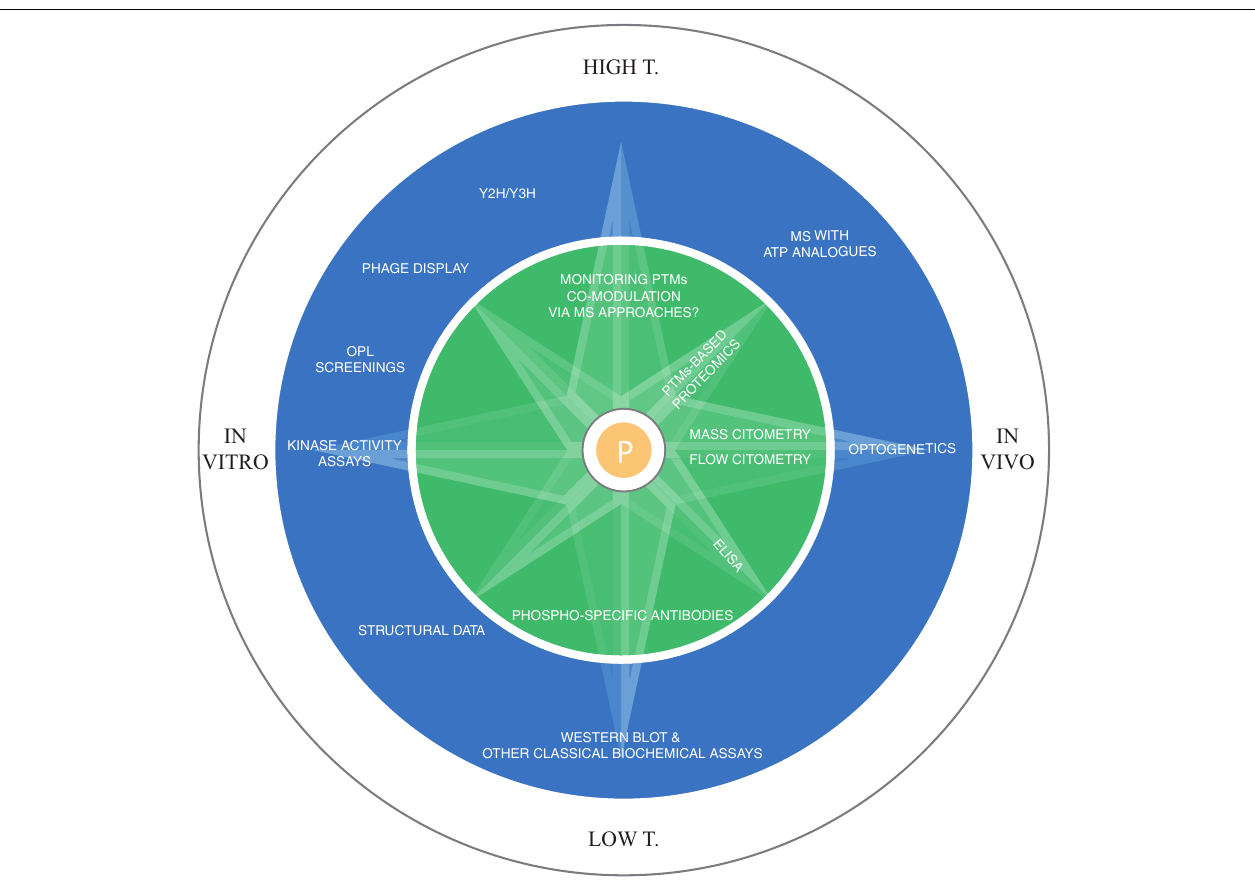
FIGURE 2 | Methodologies for the experimental identification of phosphorylation sites. In the inner circle the techniques for the detection of phosphorylation sites are reported, while the outer circle displays the major techniques for dissecting kinase-substrates interactions, both at the level of direct determination of kinase-substrate interaction (kinase activity assays, OPL, MS with ATP analogs, structural data, western blot, optogenetics) and at the contextual information generation level, i.e., the methodologies that allow the identification of interacting domain